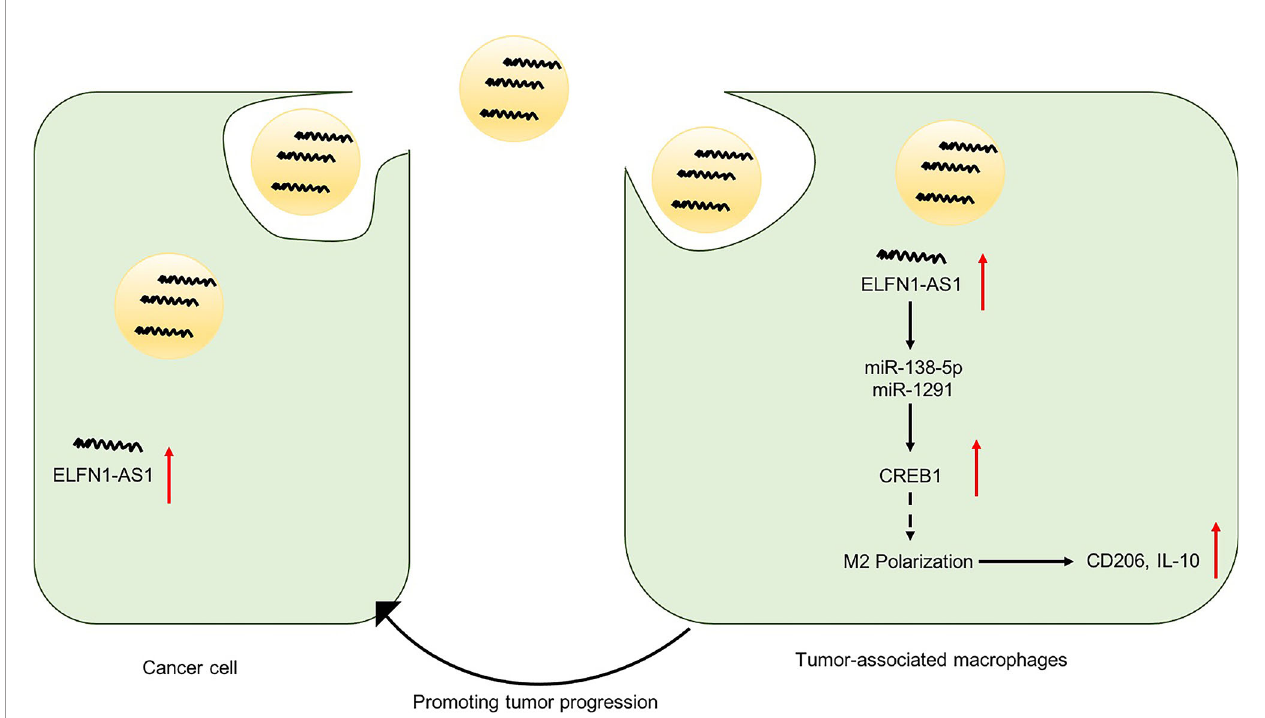
FIGURE 9 | A schematic model of ELFN1-AS1 functions in tumor progression. ELFN1-AS1 could sponge miR-138-5p and miR-1291 to promote macrophage M2 polarization in macrophages via CREB1 upregulation, which in return promote OS